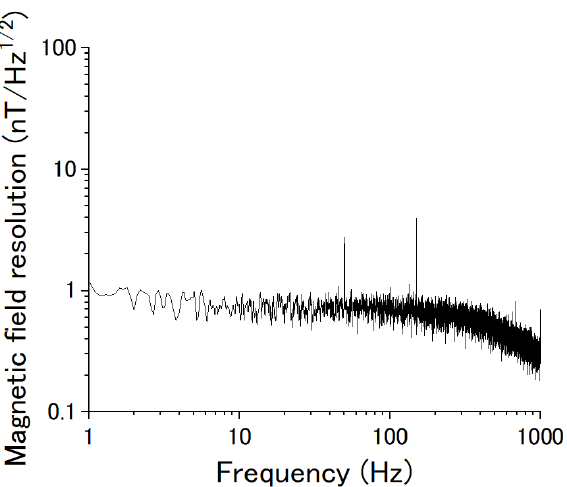
Figure 10. Magnetic field resolution of the novel type of magnetic sensor.